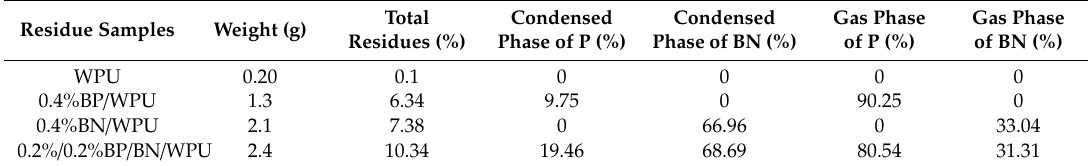
Table 3. The content of BP and BN nanosheets in the residues after the CC test.